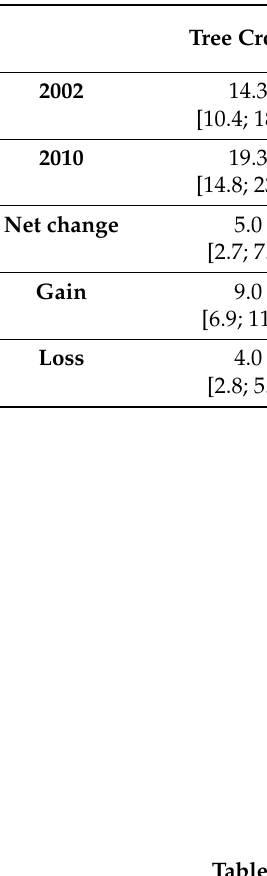
Table 3. Land cover and land cover change estimates (% of Haiti’s area) with 95% confidence intervals in brackets, for each land cover class.